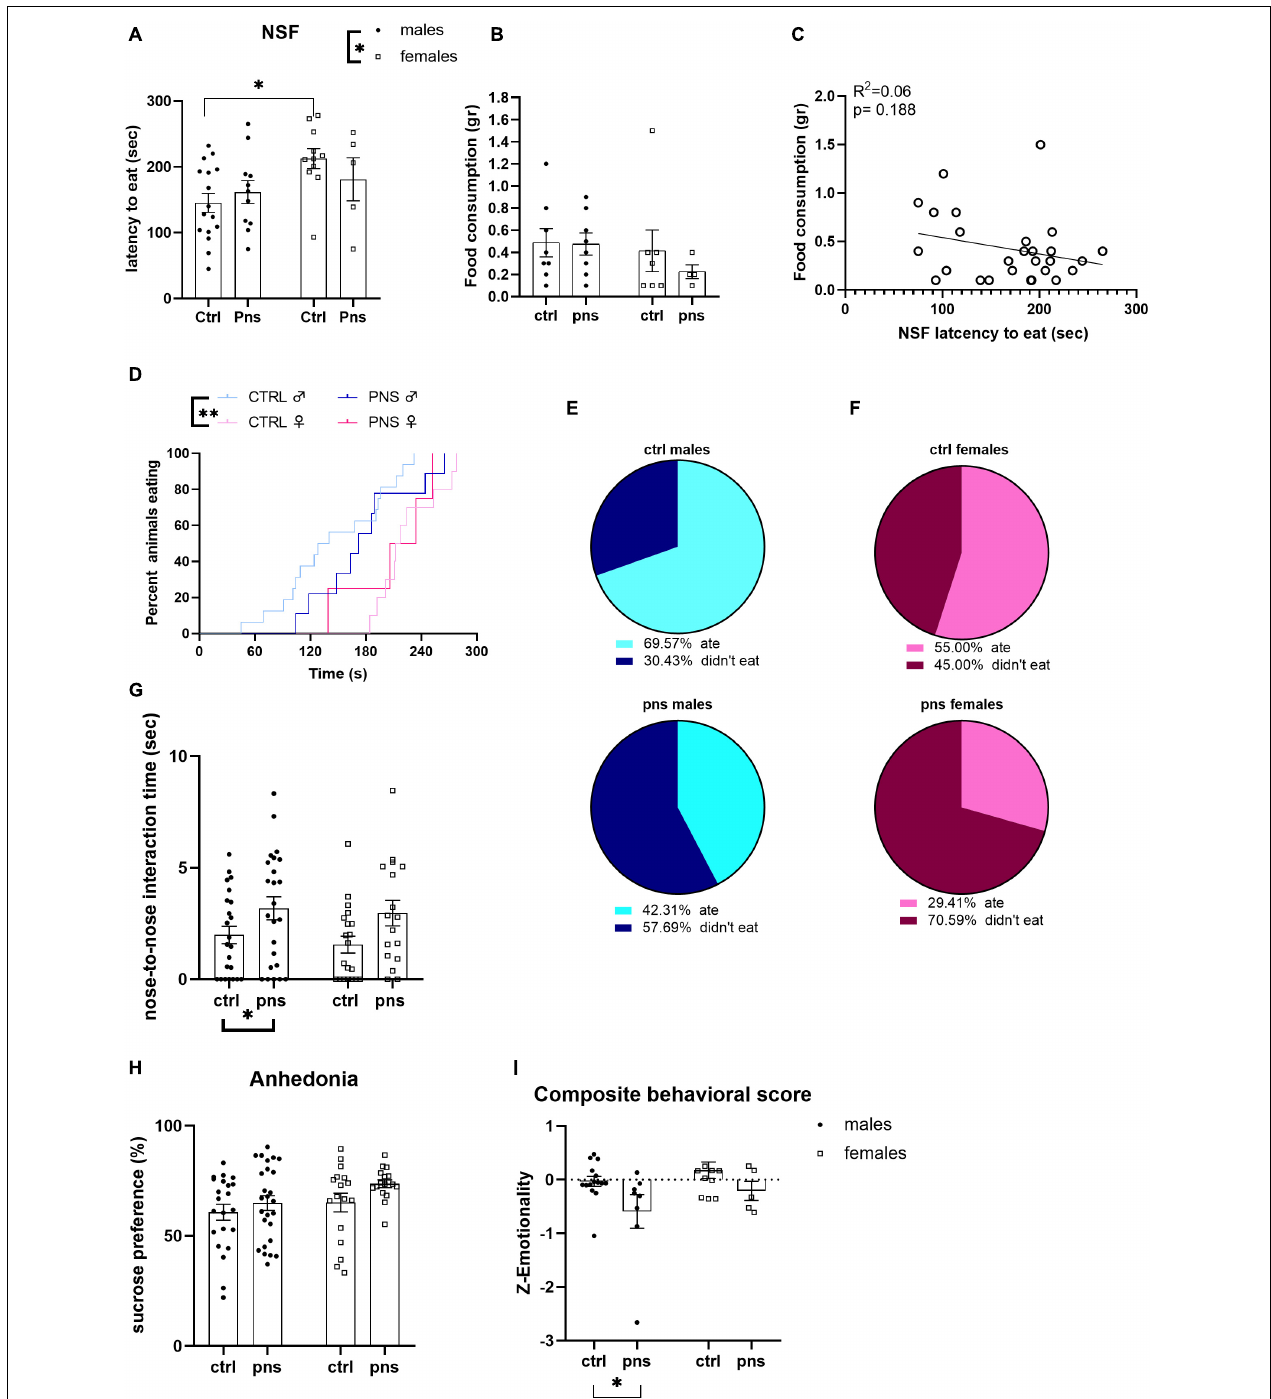
FIGURE 2 | Analysis of anxiety- and depressive-like behaviors in prenatally stressed adult rats. ( A ) Latency to eat in a novel arena [novelty-suppressed feeding (NSF)] was affected by sex but not by prenatal stress (PNS). ( B ) Amount of food consumed during the 5-min test trial is shown. ( C ) Analysis by Pearson’s product–moment correlation (R 2 ) between NSF score of latency to bite and food consumption during 5-min NSF test. Data are expressed as scatterplots, with each dot representing control or PNS male and female rats that ate the pellet during the test, and actual amount eaten could be quantified. The solid line represents the linear fit to all data points with a 95% confidence interval. ( D ) Survival plot of NSF latencies (Mantel–Cox log-rank test). ( E ) Pie charts indicate percentages (%) of male rats that ate or did not eat the pellet during the NSF test. Values in the upper chart represent eaters or not for control group. Lower chart shows percentage values for the PNS group (chi-square test). ( F ) Proportion of female rats that ate or did not eat the pellet during the NSF test. Values are the percentage (%) of eaters or not for control